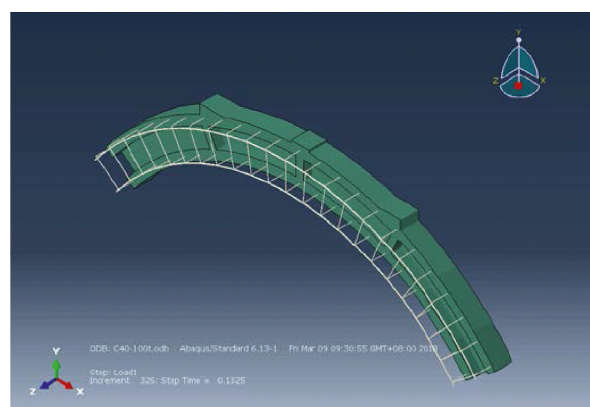
Figure 14: FEM of the UHPFRC